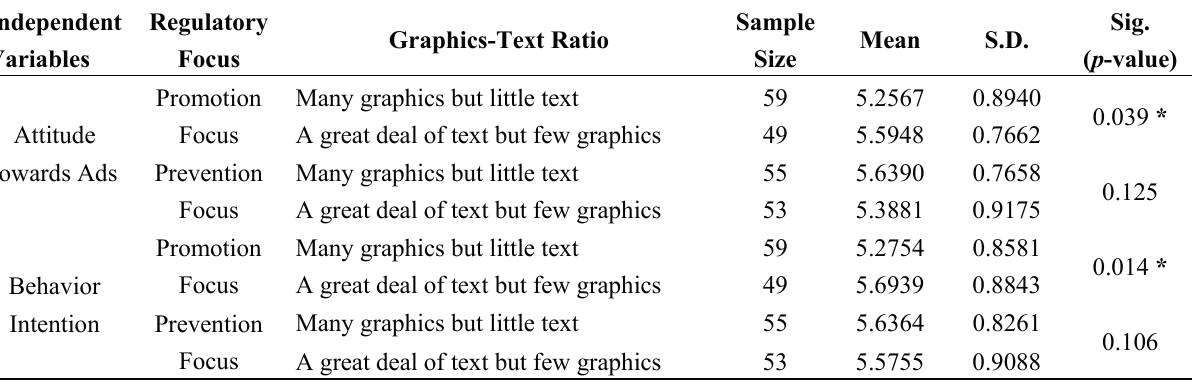
Table 7. Interactions between regulatory focus and the graphics-text ratio.